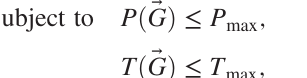
¼ 10 trips per hour and P ¼ 1200 max max